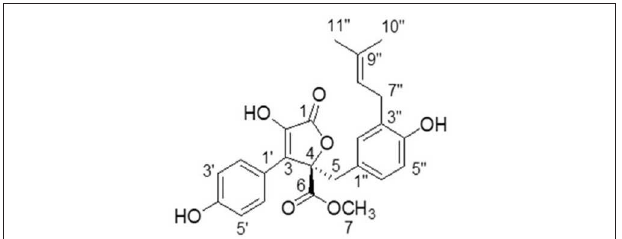
FIGURE 2 | The structure of